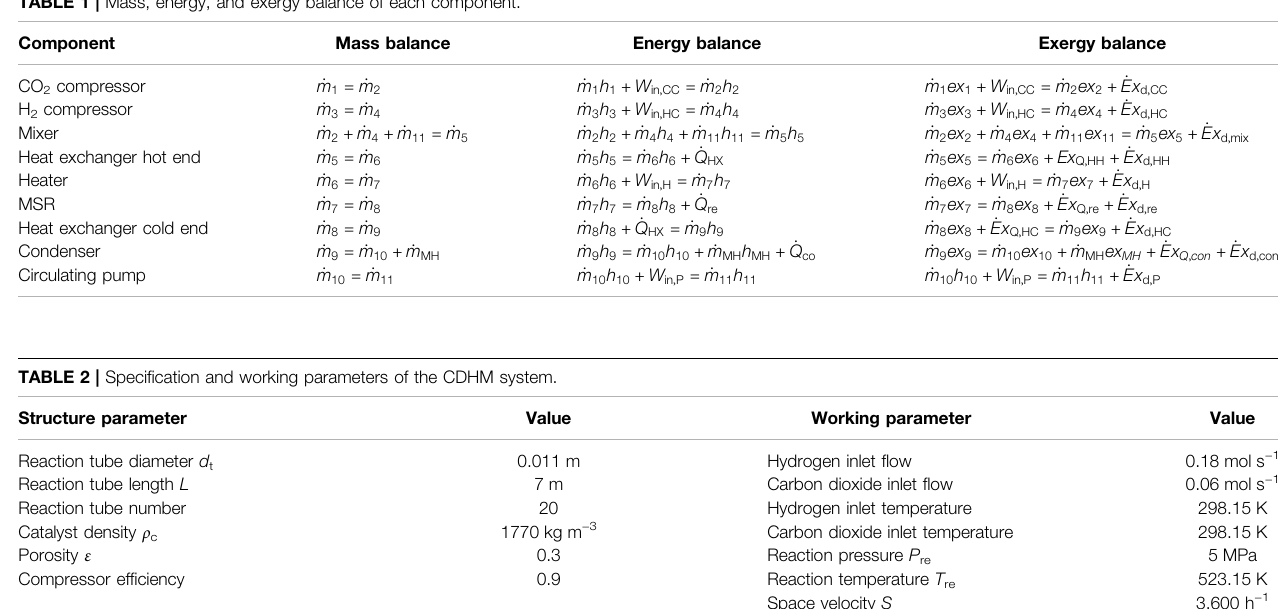
TABLE 1 | Mass, energy, and exergy balance of each component.